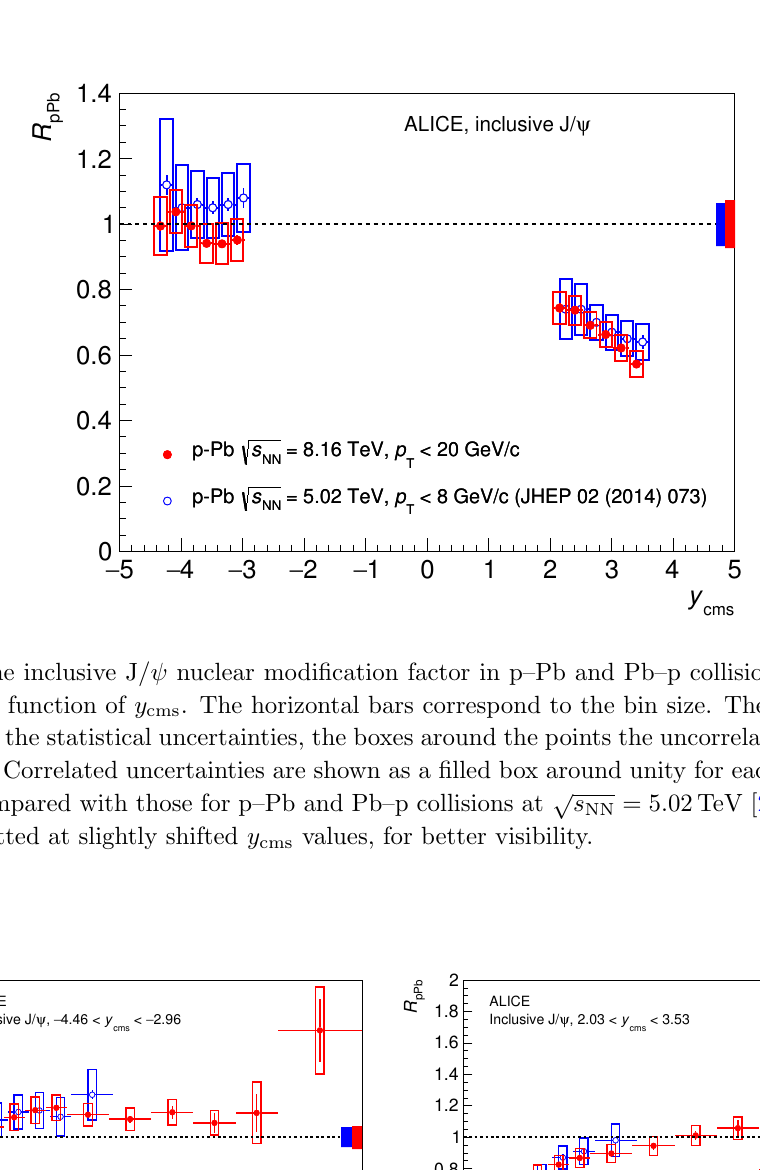
Figure 5 . The inclusive J/ nuclear modi(cid:12)cation factor in Pb{p (left) and p{Pb (right) collisions at p s NN = 8 : 16 TeV, as a function of p T . The horizontal bars correspond to the bin size. The vertical error bars represent the statistical uncertainties, the boxes around the points the uncorrelated systematic uncertainties. Correlated uncertainties are shown as a (cid:12)lled box around unity for each energy. The results are compared with those for p{Pb and Pb{p collisions at The latter have been plotted at a slightly shifted p T , for better visibility.